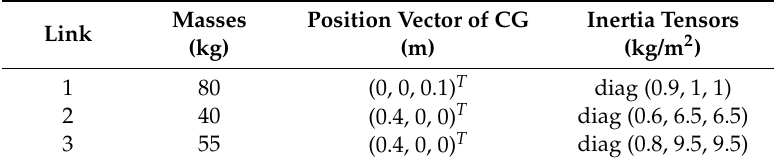
Table 1. The inertial properties of the links.